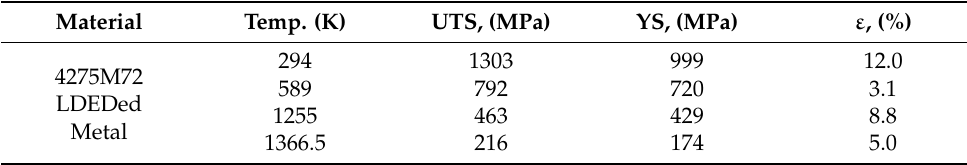
Figure 10. Vickers microhardness measurement results in as-deposited and aged 4275M72 samples along the build direction from the top layer towards the substrate. Table 5. Tensile properties of LDEDed